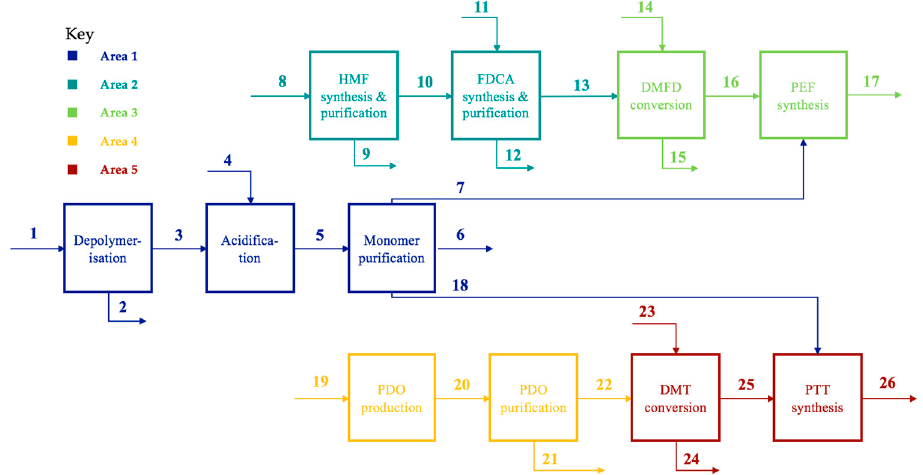
Figure 2. Expanded block flow diagram of the plastic biorefinery concept. Area 1: PET depolymeri-